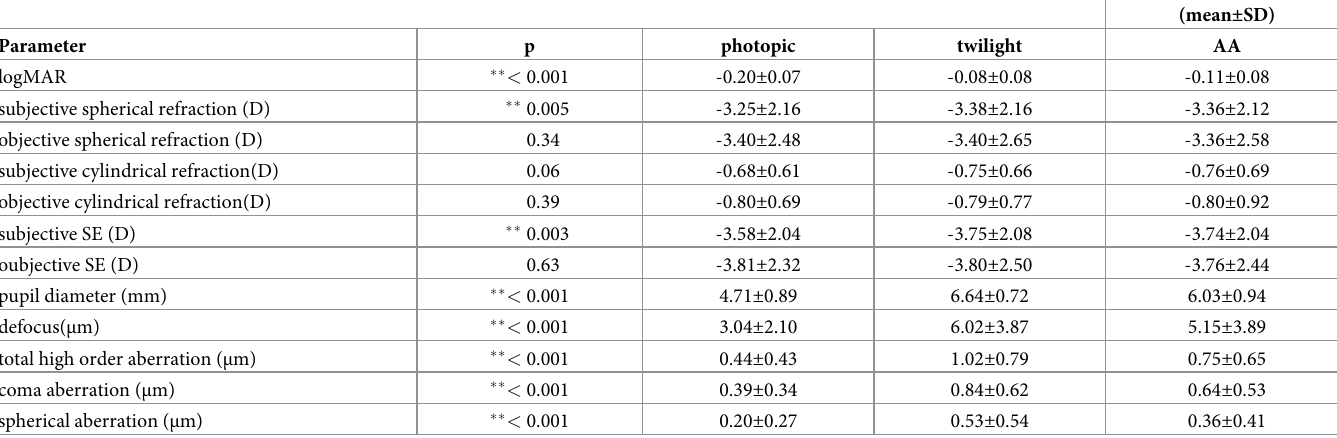
Table 1. Measurement data of the study participants (n = 20).